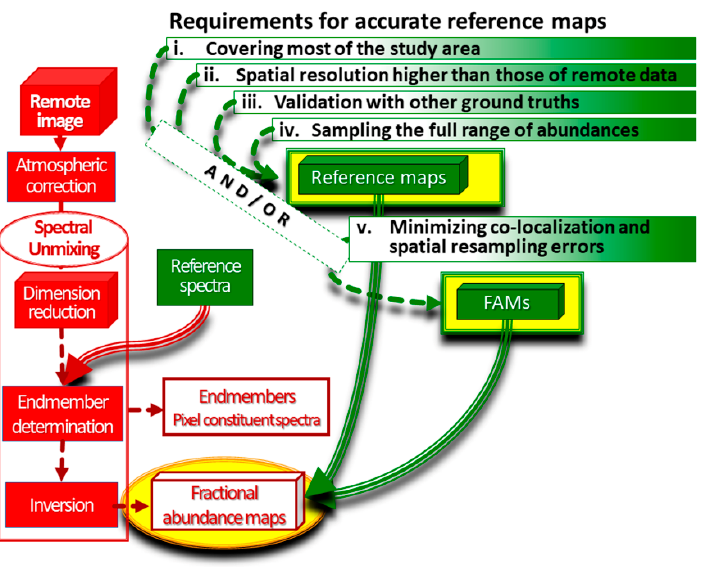
Figure 2. The flowcharts of spatial validation methods.